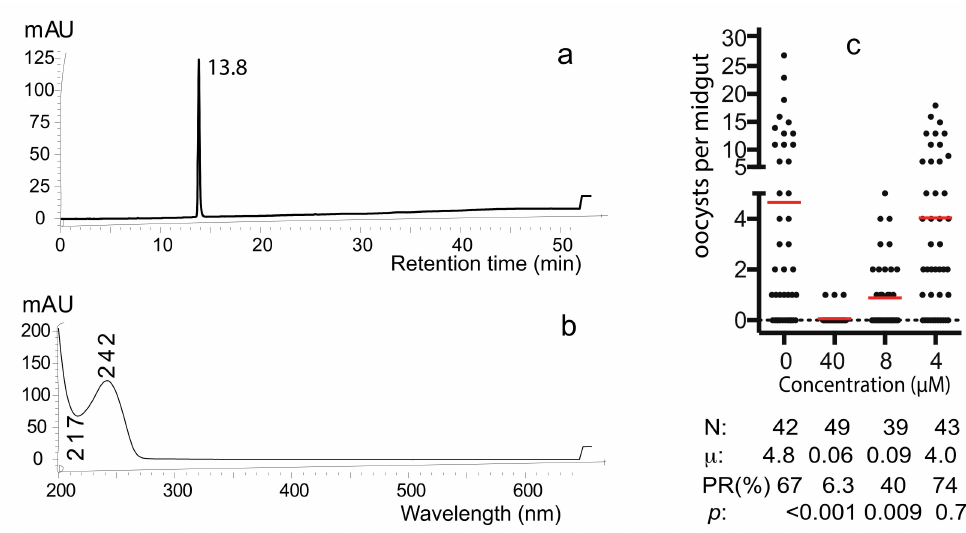
Figure 5. The characteristic profiles of the pure active compound. ( a ) HPLC profile showed one peak. ( b ) UV-Vis absorbance profile. ( c ) The pure compound inhibited P. falciparum transmission to An. gambiae in a dose-dependent manner. N: # of mosquitoes for each treatment; µ : the mean oocysts in a midgut; PR: infection prevalence in mosquitoes; p : statistical values compared to the control (no compound) by Wilcoxon